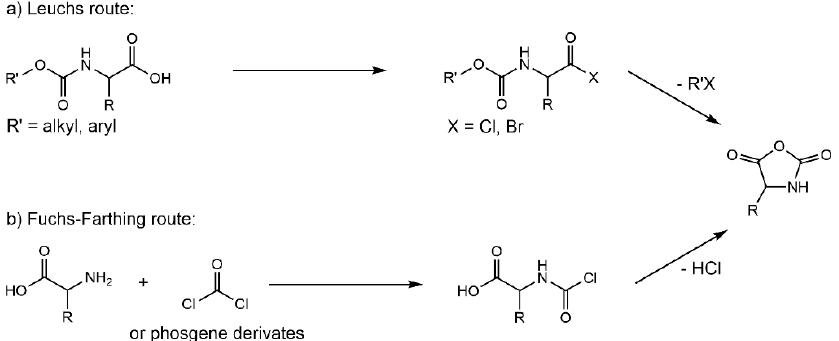
Figure 2. (a) Leuchs method to synthesize NCAs, (b) Fuchs – Farthing method to synthesize NCAs. Figure 2. ( a ) Leuchs method to synthesize NCAs, ( b ) Fuchs–Farthing method to synthesize NCAs. The ring-opening polymerization (ROP) of NCAs can produce ‘living’ polypeptides.